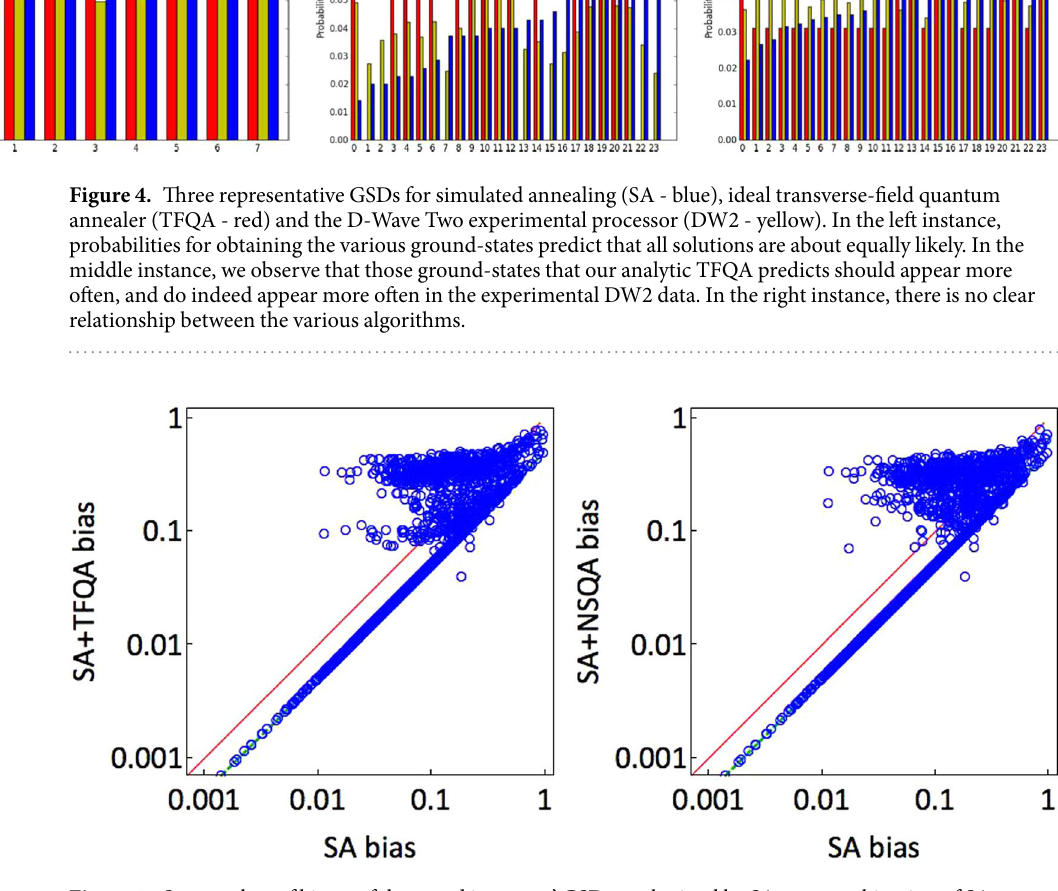
Figure 5. Scatter plots of biases of the tested instances’ GSDs as obtained by SA vs. a combination of SA with ideal quantum annealers. Left: SA vs. SA + TFQA. Right: SA vs. SA + NSQA. In the majority of cases, a combination of the methods leads a smaller overall bias, i.e., a lesser degree of unfairness. The solid red line is the ‘equal bias’ y = x line, whereas the dashed green y = x /2 line is the bias obtained when SA is combined with a flat, unbiased GSD, in which case the bias is